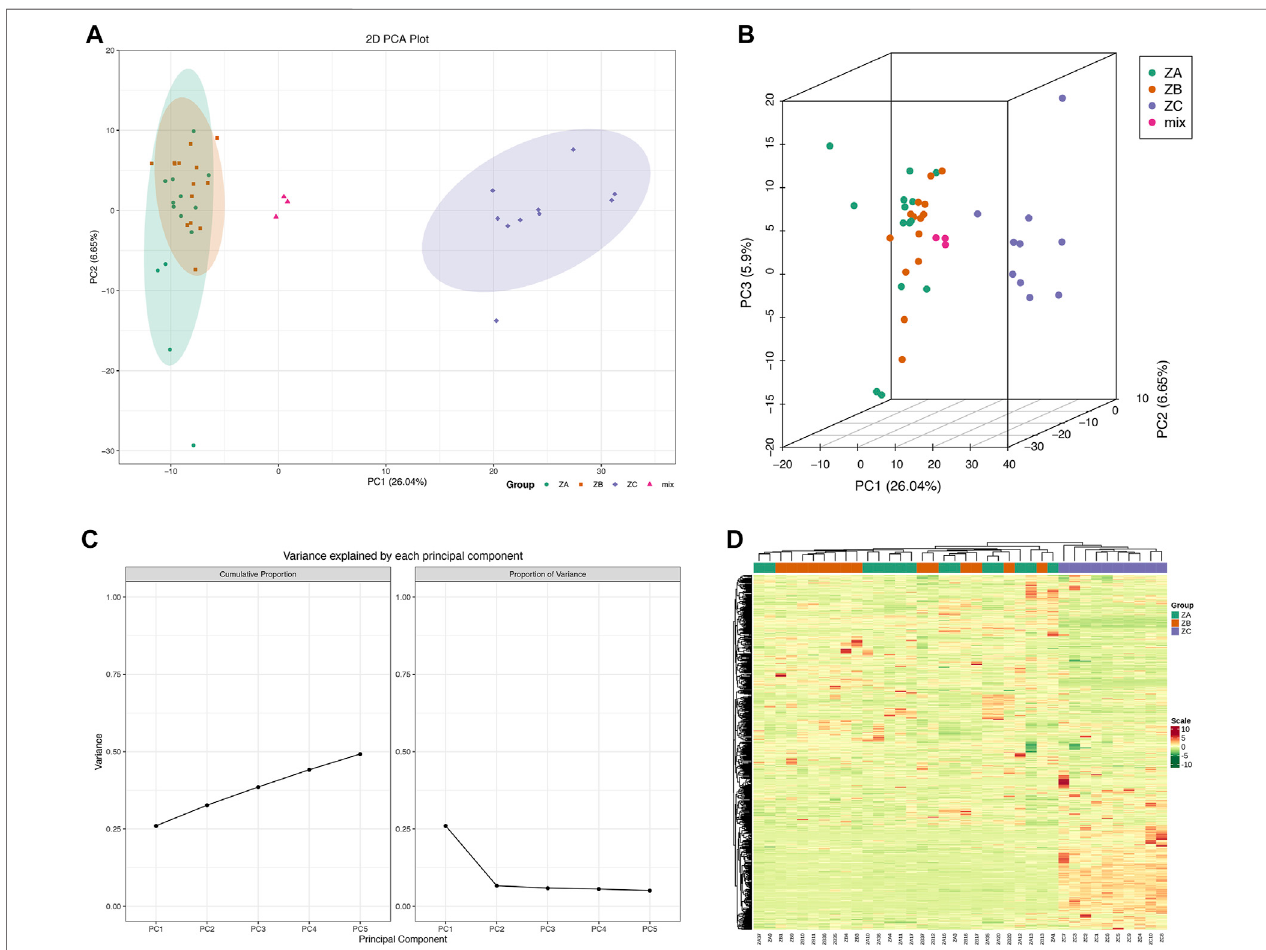
FIGURE 1 | Serum metabolites identi fi cation based on principal component analysis (PCA) and hierarchical cluster analysis (HCA). ( (A) Serum metabolites plot based on PCA in two dimension; (B) serum metabolites plot based on PCA in three dimension; (C) PCA with multiple variance characteristic; (D) serum metabolites heatmap based on HCA; ZA, Zuojin pill (ZJP) after treatment; ZB, ZJP before treatment; ZC, ZJP control as healthy people; mix: quality control).